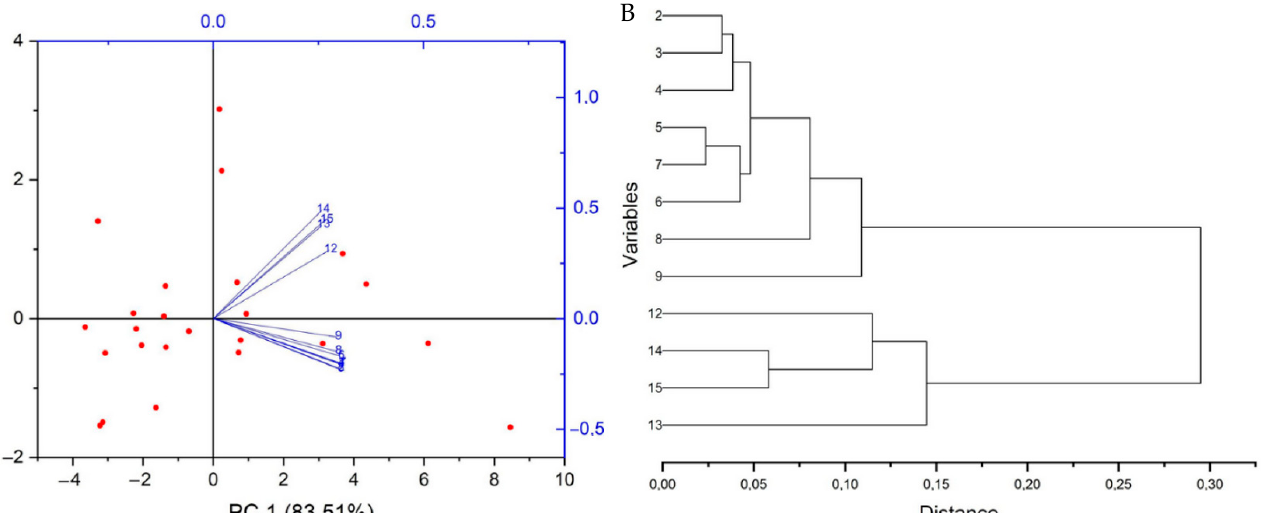
Table 6. Average percentage change in physicochemical parameters below the Sadowice, Ska ł ka, and Marszowice hydro- power plants.